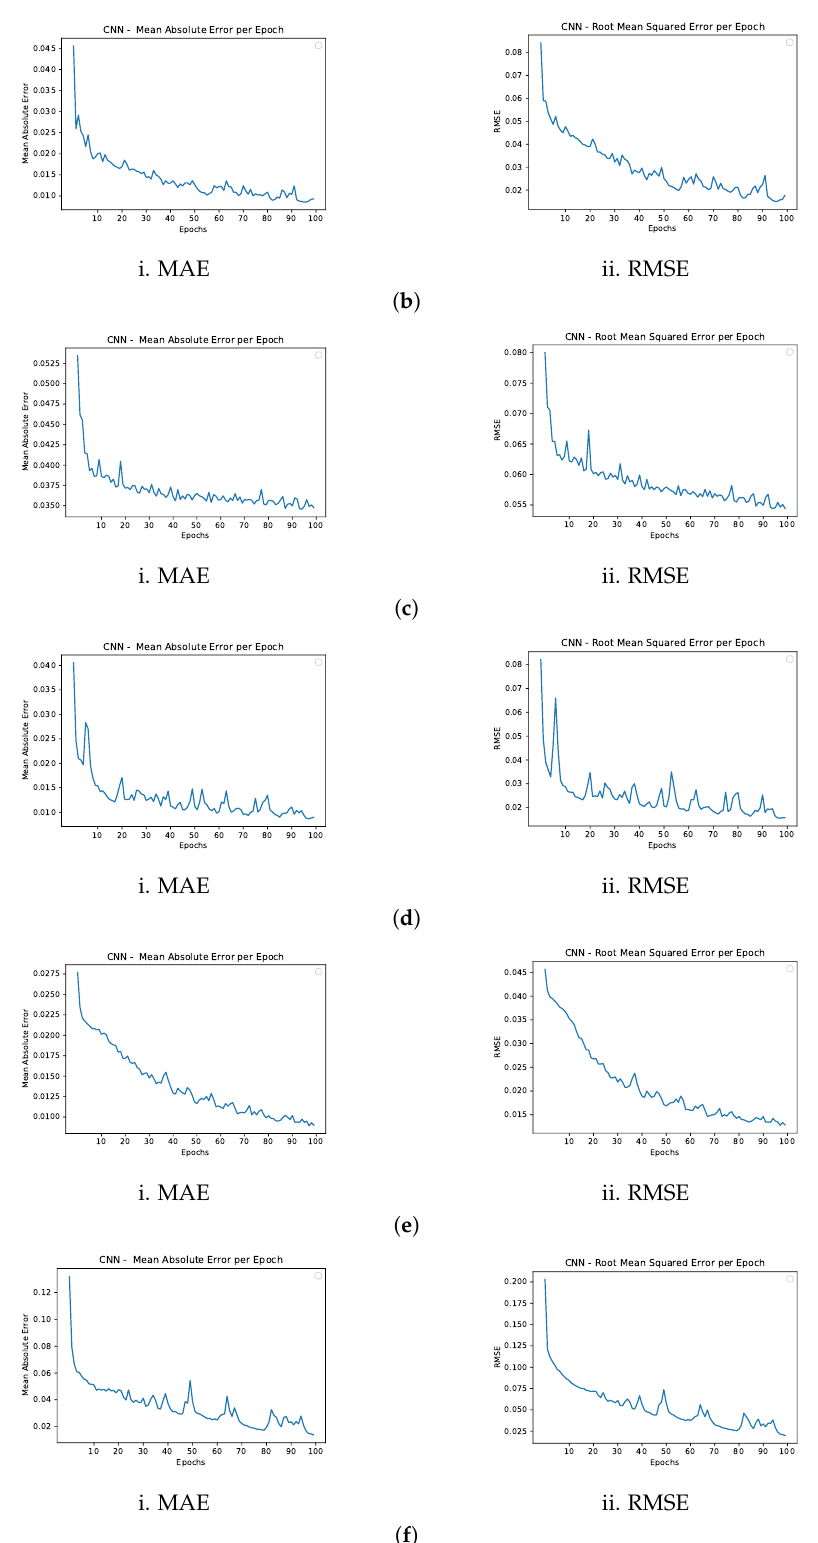
Figure 12. Metrics for the CNN Model. ( a ) Error Metrics for ANL-Intrepid-2009-1 Dataset. ( b ) Error Metrics for CEA-Curie-2011-2 Dataset. ( c ) Error Metrics for CIEMAT-Euler-2008-1 Dataset. ( d ) Error Metrics for KIT-FH2-2016-1 Dataset. ( e ) Error Metrics for METACENTRUM-2013-3 Dataset. ( f ) Error Metrics for UniLu-Gaia-2014-2